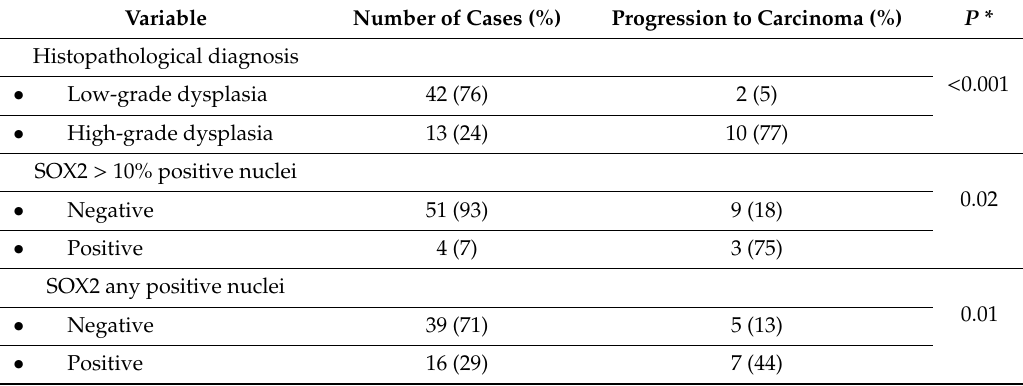
Table 3. Univariate Cox cancer-free survival analysis in 55 patients with oral dysplasia categorized by dysplasia grading and SOX2 expression.